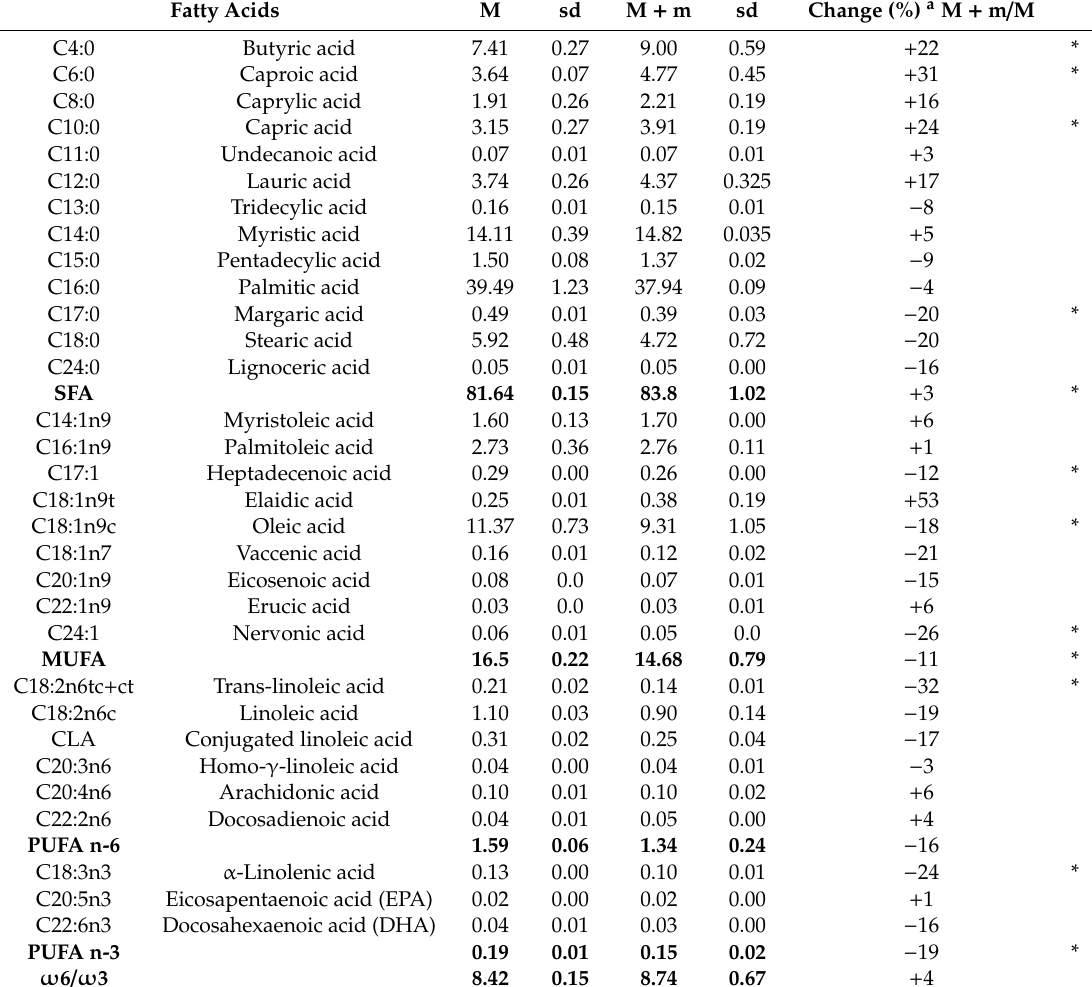
Table1. Fattyacidcompositionofmilkobtainedfrombu ff aloesfednonmycorrhizal(M)andmycorrhizal (M + m) maize silage (% weight of total methyl esters; mean ± standard deviation). SFA, saturated fatty acid; MUFA, monounsaturated fatty acid; PUFA, polyunsaturated fatty